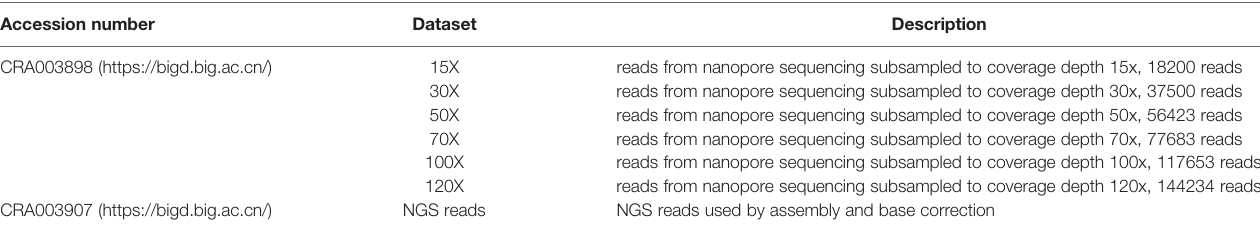
TABLE 1 | Basic information of the datasets used for